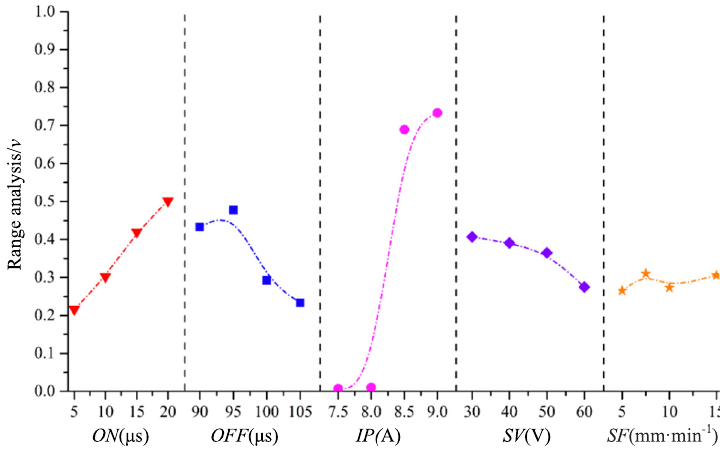
Figure 5: Trend chart of in fl uence on cutting speed.